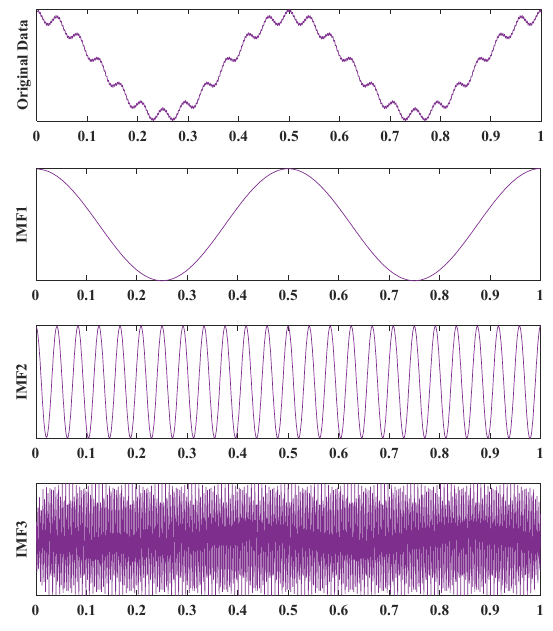
Figure 1. Decomposition results of analog signals based on VMD. Using the instantaneous frequency mean value method, the decomposition is divided into deformed sub-sequences with different modulus, and the instantaneous frequency mean values of the components under different K values are calculated. The specific calculation results are shown in Figure 2. It can be seen that when K ≥ 4, each component has a certain degree of modal confusion. Therefore, for analog signals, K = 3 is the best decomposition modulus, which is consistent with the preset K value. It is proved that the method is effective in selecting the modulus of VMD.